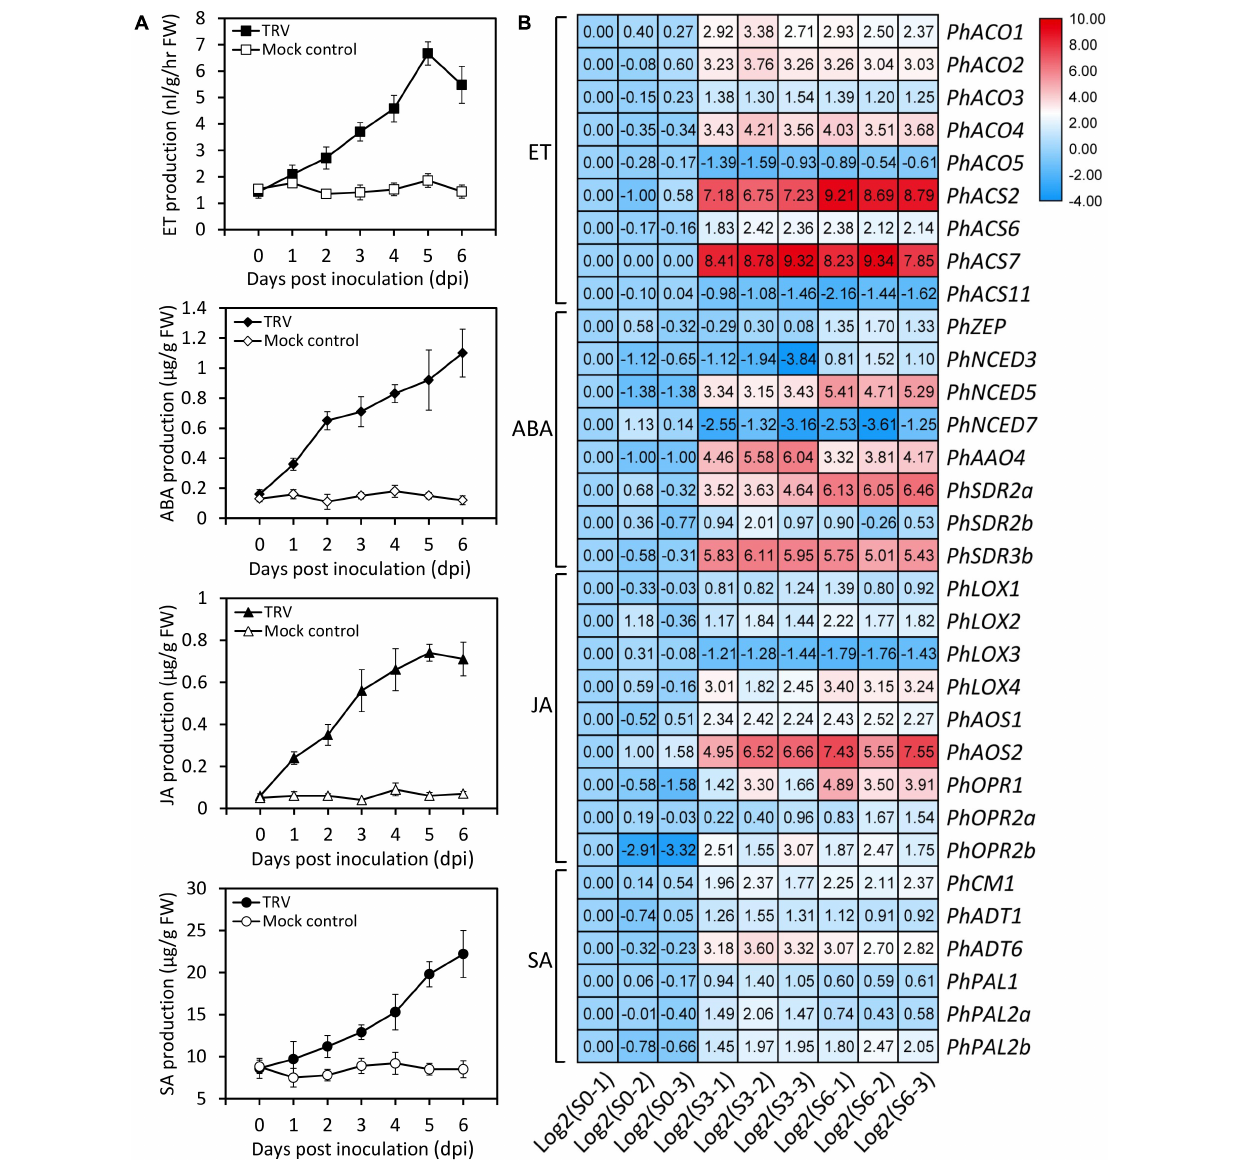
FIGURE 3 | Increased accumulation of several endogenous hormones and transcription of hormone biosynthetic genes by TRV PPK20 infection. (A) Accumulation levels of ethylene (ET), abscisic acid (ABA), jasmonic acid (JA), and salicylic acid (SA) in petunia leaves at various days post inoculation with TRV (PPK20). Error bars represent standard error of the mean from three biological replicates. (B) Expression levels of ET, ABA, JA, and SA biosynthesis-related genes in petunia leaves at three stages of TRV (PPK20) infection based on transcriptome data. The FPKMs of unigenes at the stage of S0-1 are normalized to 1.00, and transcript levels of all unigenes are transformed with